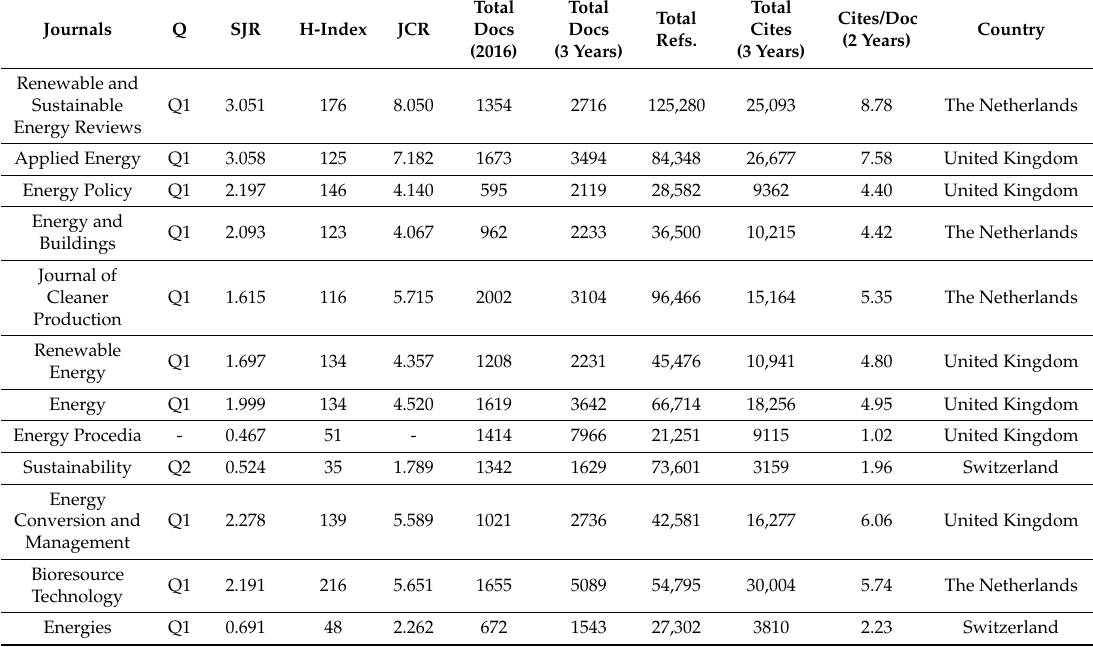
Table 3. International journal classification according to the impact factor of scientific